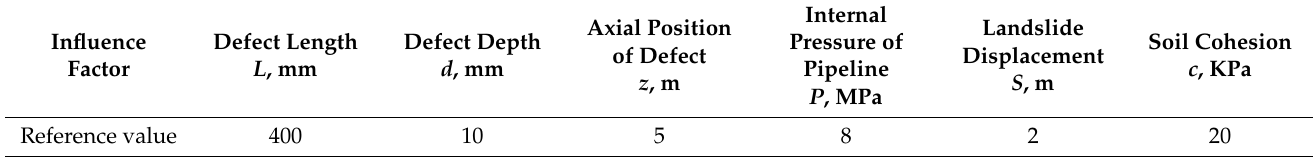
Table 3. Reference values of sensitivity